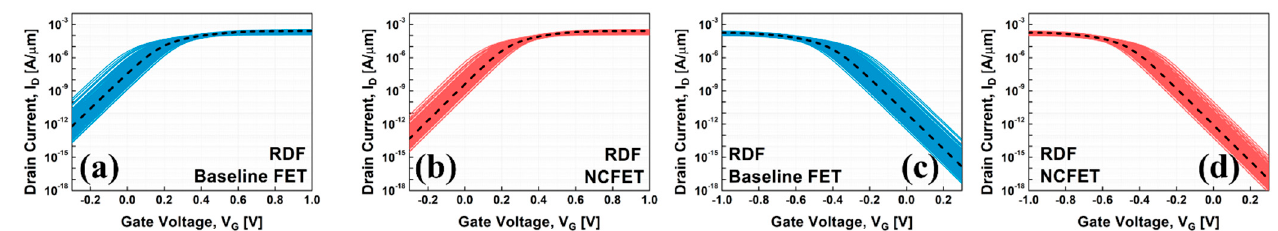
Figure 4. Simulated I DS - V GS curves ( a ) for n-type JL-NWFET (JL) and ( b ) for n-type NC-JL-NWFET (NC-JL) with RDF. I DS V GS curves ( c ) for p-type JL-NWFET (JL) and for ( d ) p-type NC-JL-NWFET (NC-JL) with RDF. The dotted line indicates the nominal I DS - V GS for JL-NWFET and NC-JL-NWFET. Table 3. Variation parameters of n-/p-type JL-NWFET and NC-JL-NWFET in linear and saturation mode with random dopant fluctuation.